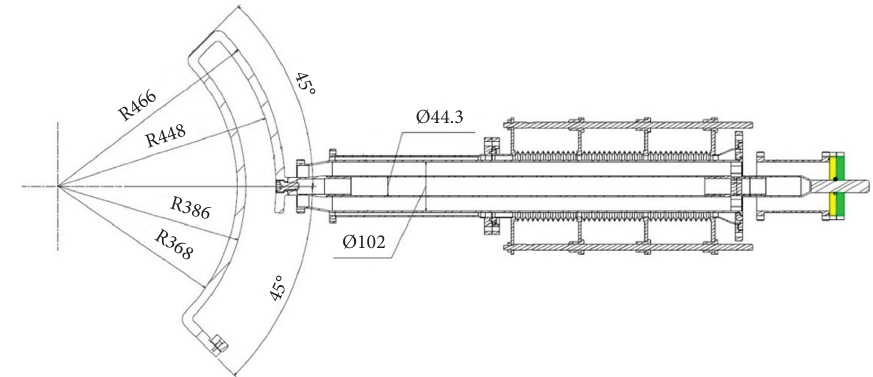
Figure 3: Detailed view of the strap connection with TL.